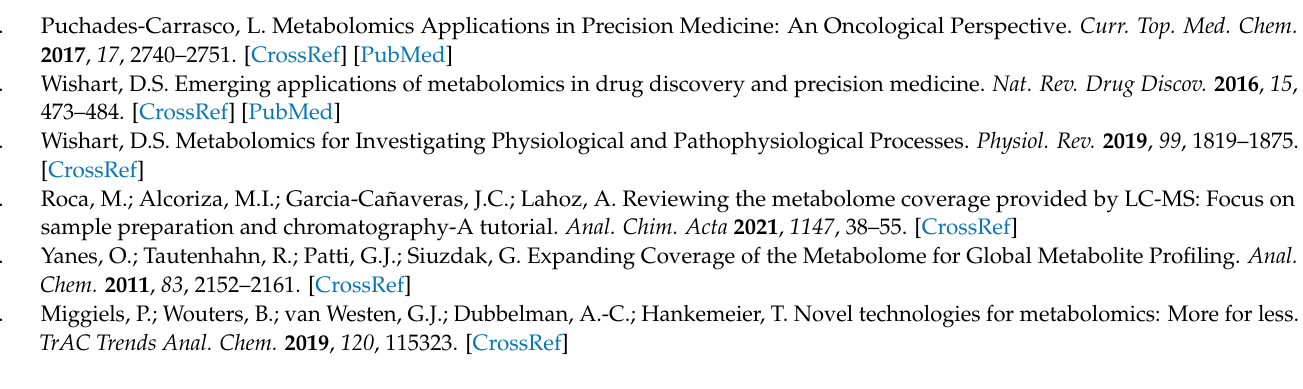
ESI (-), Table S1: Mass spectrometer parameters during the analysis of lipid (RP) and polar (HILIC) extracts, Table S2: Comparison of extraction methods: the average number of extracted metabolites in three replicates, standard deviation, and number of metabolites common to all three replicates, Figure S2: PCA models built on datasets obtained during robustness testing using the